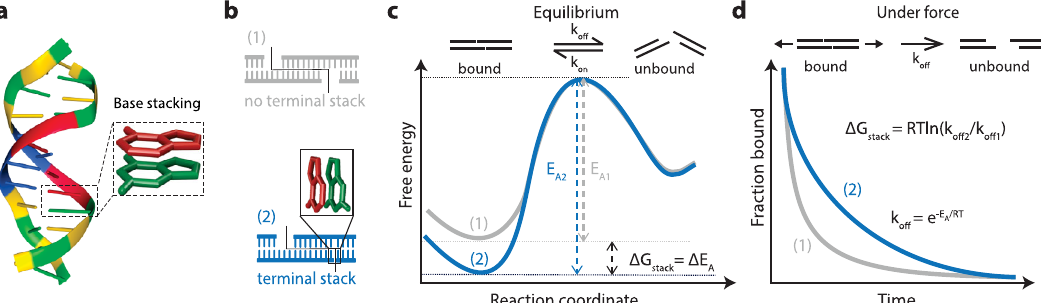
Fig. 1 | Conceptual overview. a Model of a DNA duplex 66 with enlarged frame showingstackedadjacentbases. b Designoftwoduplexesdifferingbyasingle-base stacking interaction. c Free-energy diagram of a DNA duplex with and without a terminal base stack. The base stack primarily increases the activation energy from